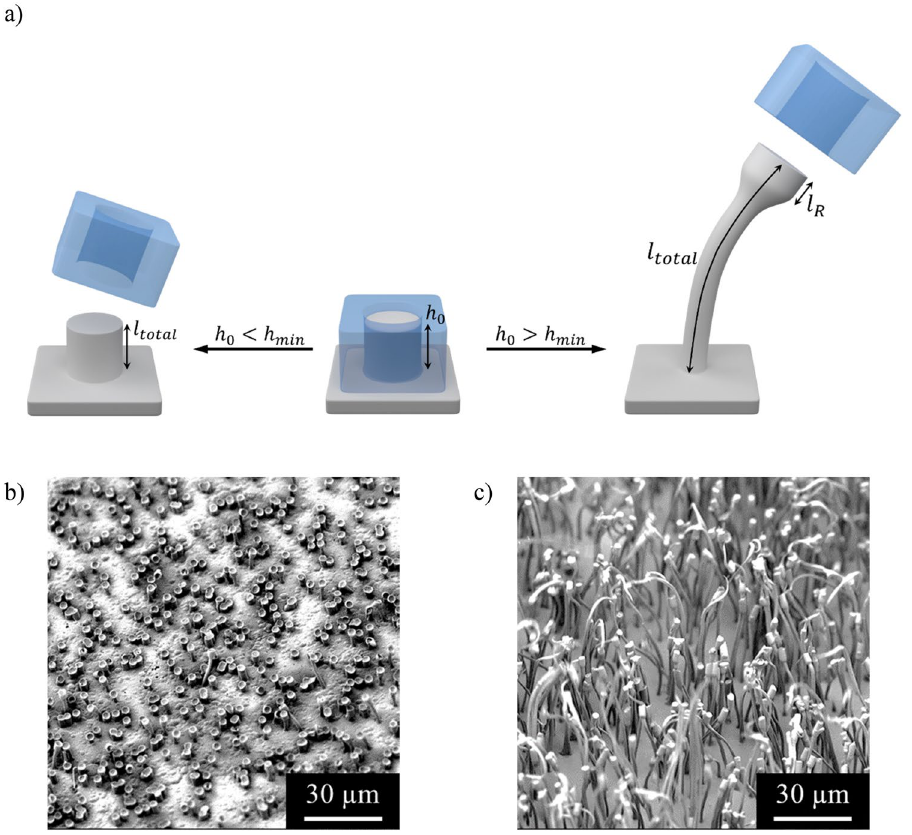
Figure 7. ( a ) Contact time dependence of the draw ratio. Depending on the filling level h 0 simple replication of the pores takes place or the process of cold stretching to hairy structures. SEM image of a patterned HDPE sample with PC-3 μm at ( b ) T = 150 °C , t = 300 s , no stretching takes place due to insufficient rise height, h 0 < h min . ( c ) T = 150 °C, t = 600 s, the rise height increased by longer contact time which leads to successful stretching of the structures, h 0 > h min